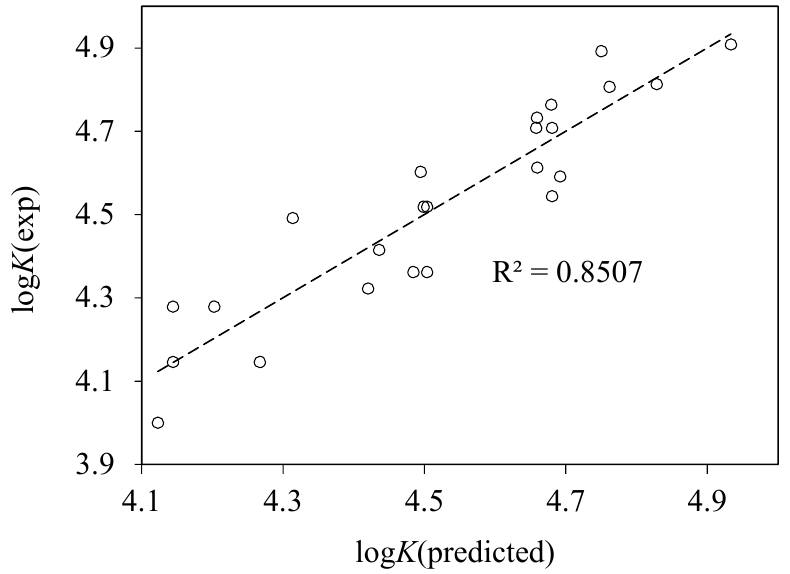
Figure 7. Plot of the experimental vs. predicted logarithms of binding constants log K obtained using the best three-parameter model (Equation (8)) with parameters from PaDEL descriptor set.